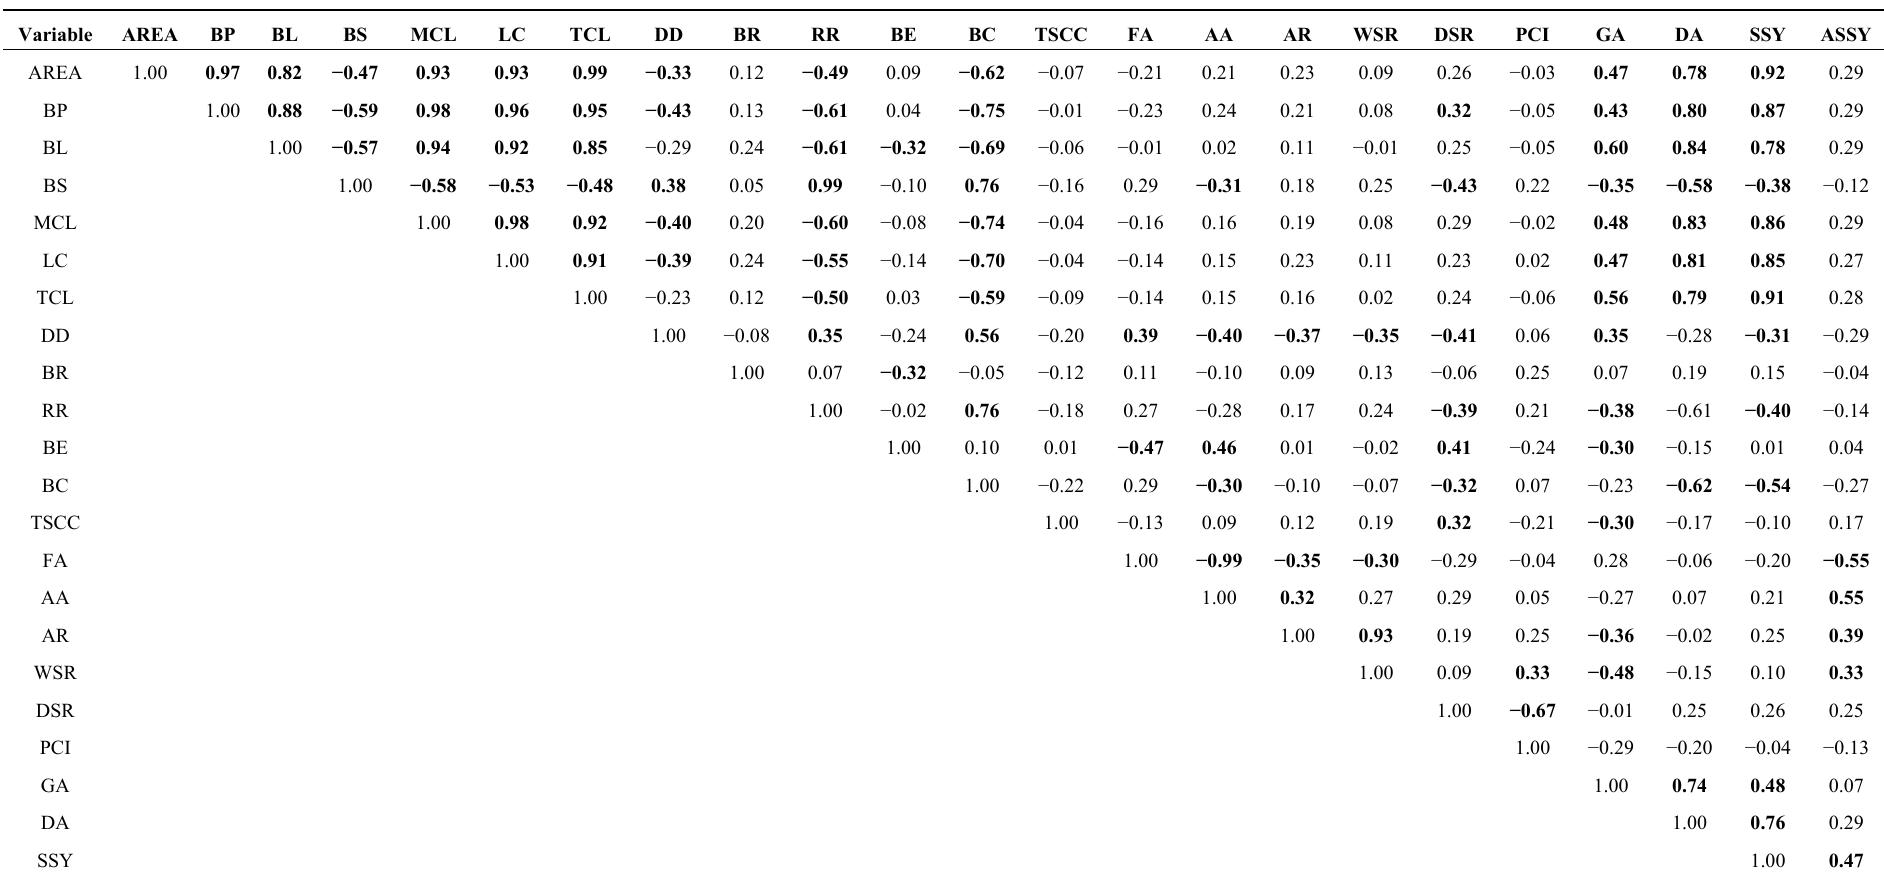
Table 4. Correlation matrix of the identified